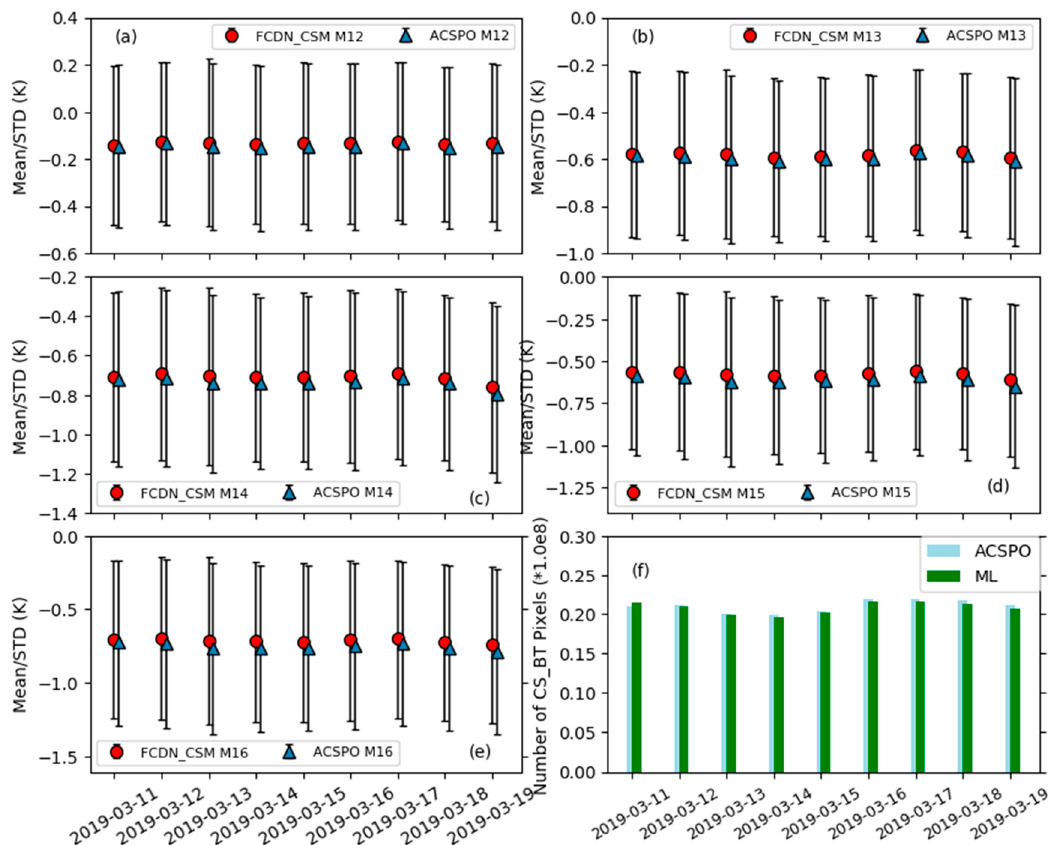
Figure 6. The M-O mean and STD error bars by using ACSPO CSM and FCDN_CSM for nine-day data from 11 to 19 March 2019 for ( a ) M12, ( b ) M13, ( c ) M14, ( d ) M15, and ( e ) M16, and corresponding NCSPs ( f ).